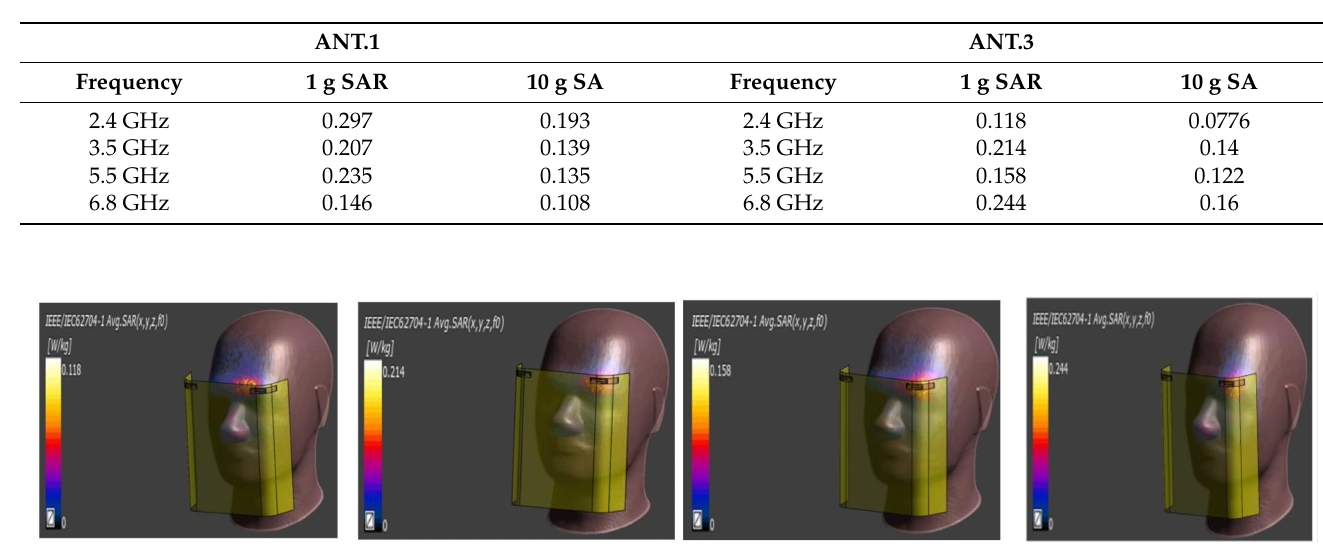
Figure 38. The 10 g SAR simulation results of Ant. 3 at 2.4 GHz, 3.5 GHz, 5.5 GHz, and 6.8 GHz.